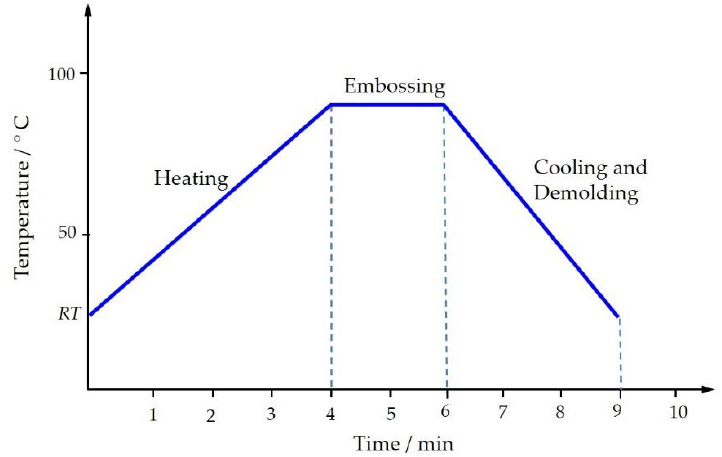
Figure 2. The thermal embossing method. ( a ) Schematic diagram of the in situ thermal embossing machine. ( b ) Thermal embossing process of a PET film mold.